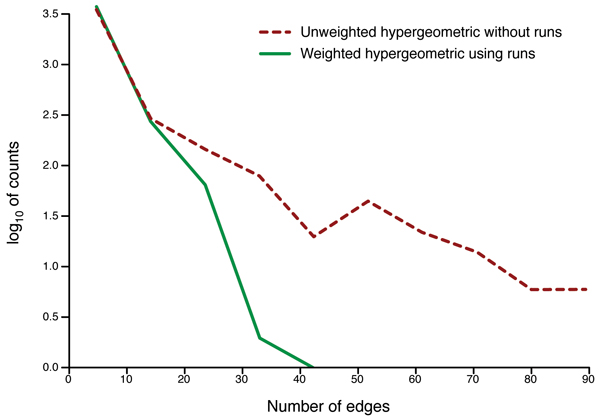
Network degree distribution. We show the edge distribution for two networks, one built using the top 5,000 pairs according to the unweighted hypergeometric metric without runs and one from our runs-employing two-term model. We see that the unweighted hypergeometric network contains many more edges of high degree. In particular, nodes with more than 40 edges are almost completely absent from the runs network while being abundant in the unweighted hypergeometric network. This suggests that the runs-informed network contains smaller and more interpretable clusters.